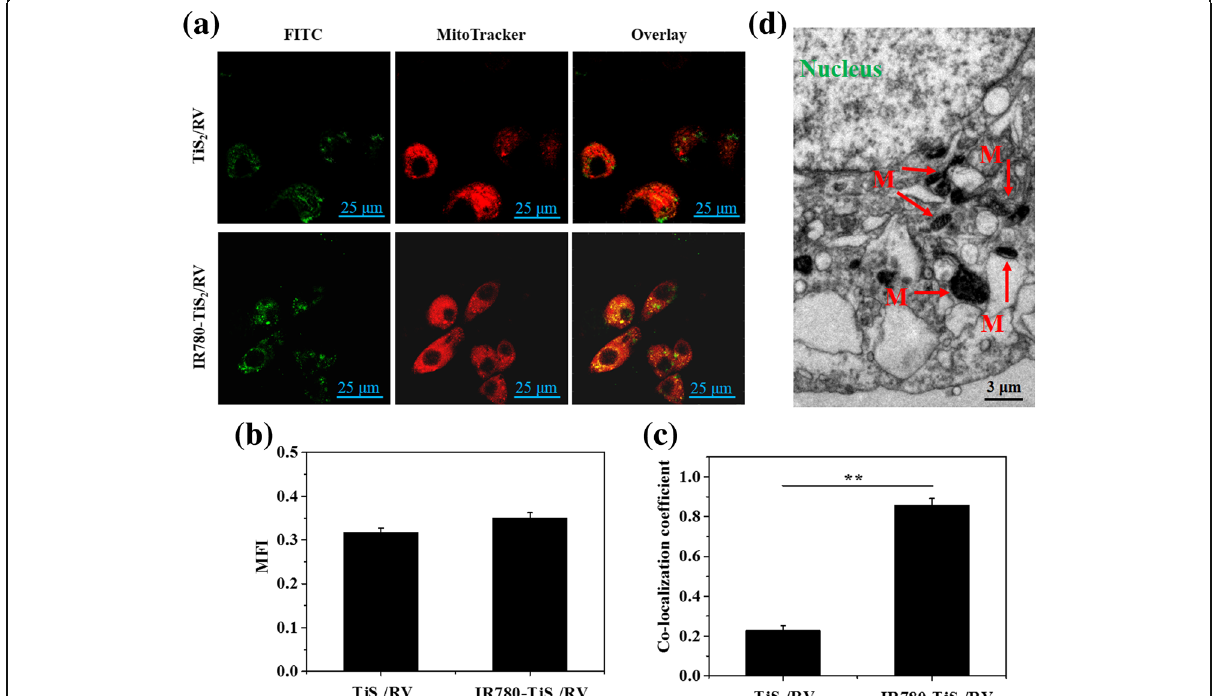
Fig. 3 a The fluorescence images of CT26 cells incubated with FITC-labeled TiS 2 /RV or IR780-TiS 2 /RV for 5 h. Green fluorescence is the FITC signal, and red fluorescence is MitoTracker signal. b The corresponding mean fluorescence intensity (MFI) analysis of FITC-labeled TiS 2 /RV or IR780-TiS 2 / RV in cells in Fig. 3a. c The corresponding co-localization coefficient of FITC-labeled TiS 2 /RV or IR780-TiS 2 /RV and mitochondria in cells in Fig. 3a. M means mitochondria . **P < 0.01, compared with TiS 2 /RV group